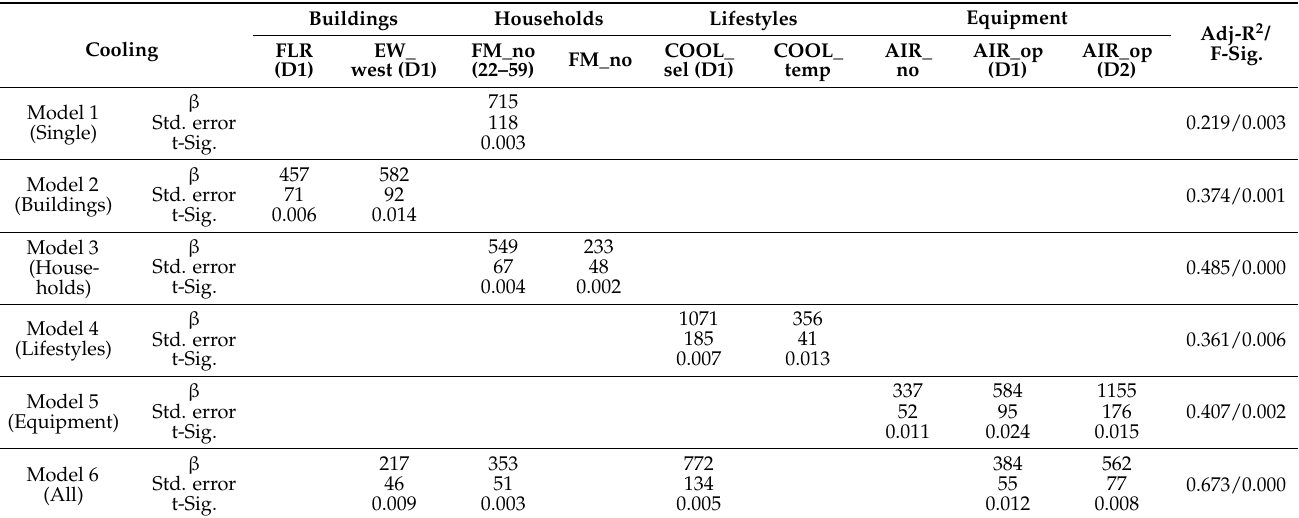
Table 6. Analysis results of valid determinants for cooling.